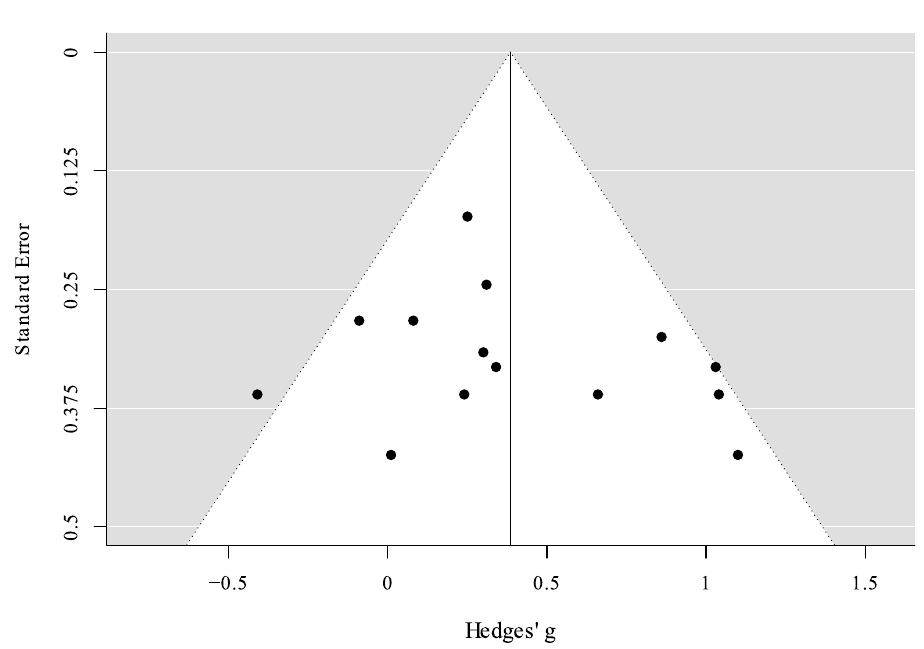
Figure 4. Funnel plot. Black dots represent studies included in the present meta-analysis. The vertical line represents the effect